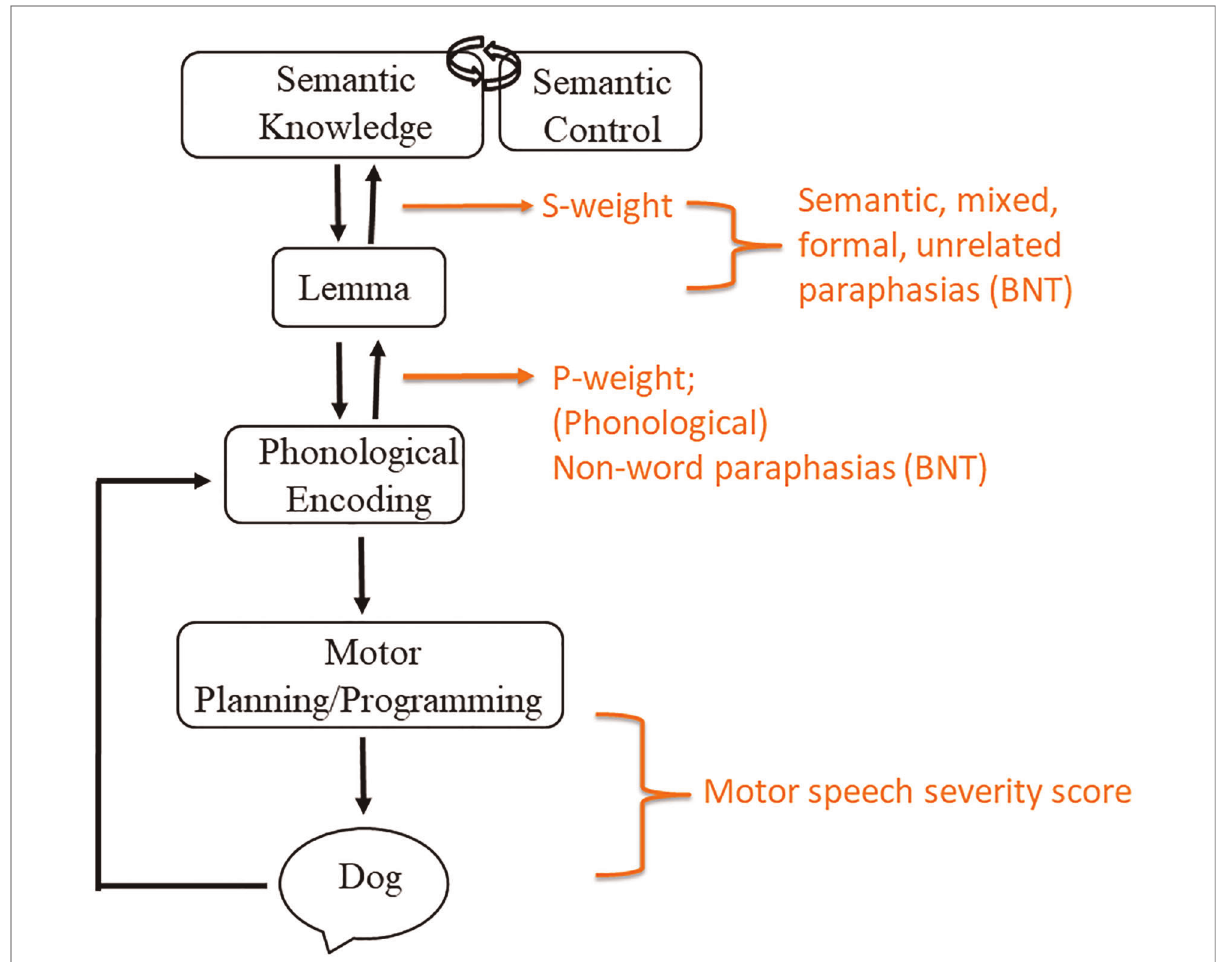
FIGURE 3 Model of expressive language and associated assessments. Model is informed by language processing models by Dell and colleagues (14), Foygel and Dell (34), and Indefrey and Levelt